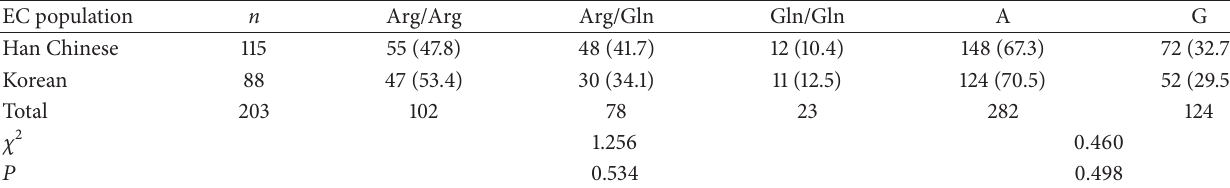
Table 2: Analysis of correlation between the XRCC1 Arg399Gln polymorphism and susceptibility to esophageal cancer by nationality ( 𝑛 (%)).